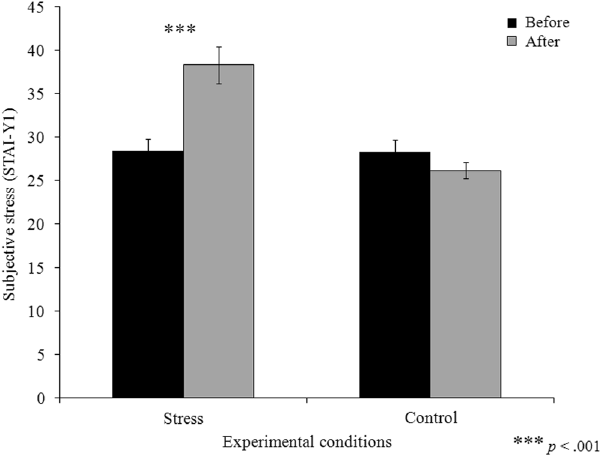
Figure 3. Comparison of participants’ subjective stress levels between experimental